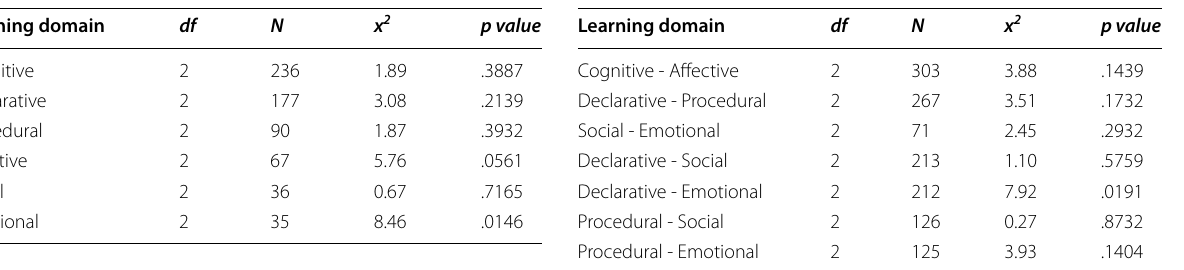
Table 5 Differences between learning domains and grade bands: chi‑square statistics (x 2 ) test for independence